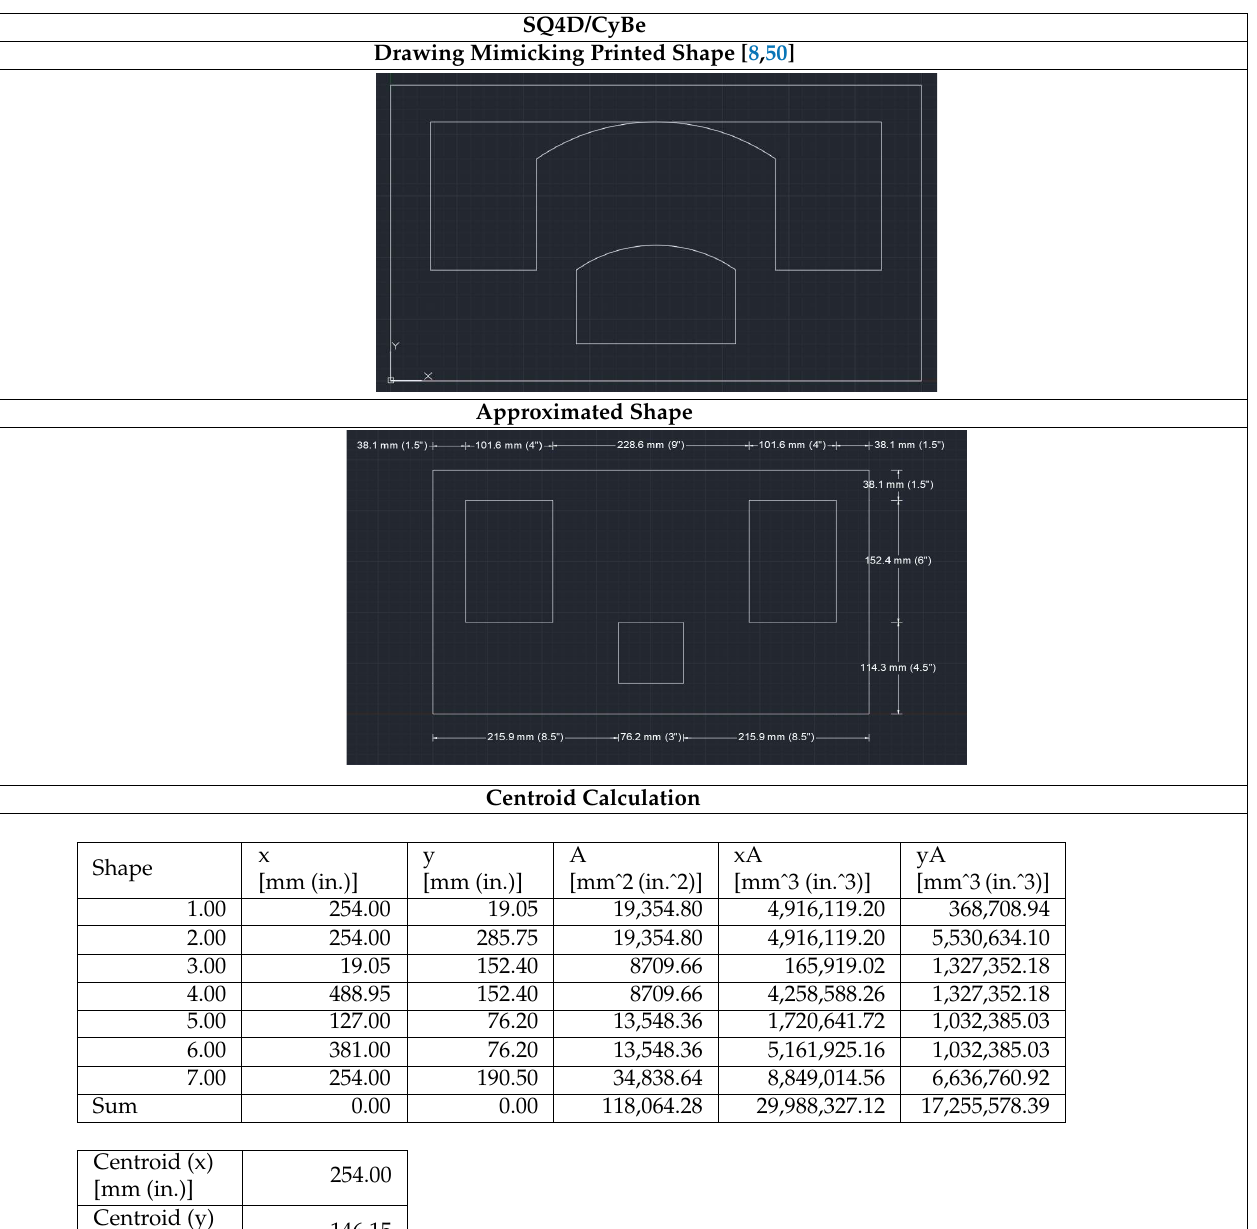
Table A5. SQ4D/CyBe wall calculations.